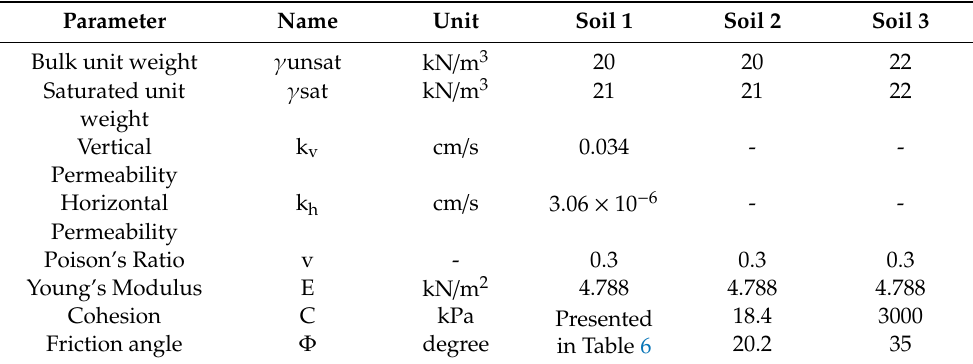
Table 5. Soil parameters for FEM analysis.